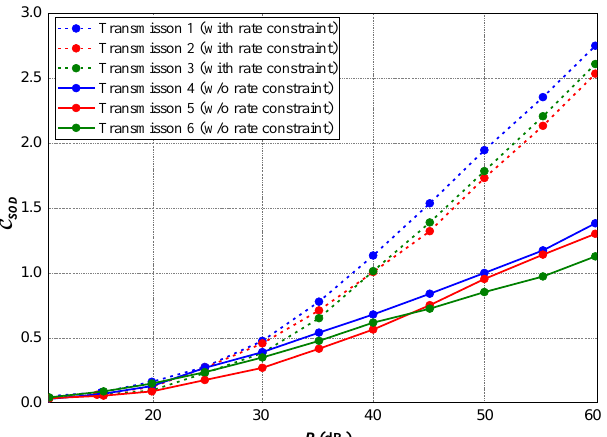
Figure 8. Source-to-Destination data rate for multiple sources transmission.